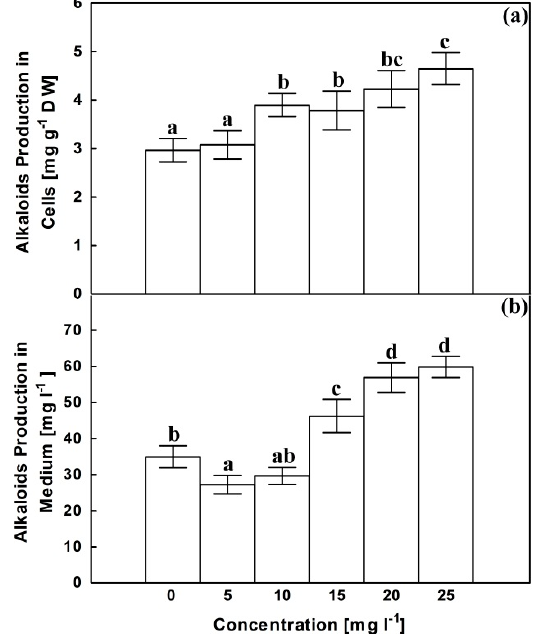
Figure 4. Effects of AgNPs at concentrations of 5, 10, 15, 20 and 25 mg L − 1 on alkaloids content in dried cells ( a ) and growth medium ( b ) of C. roseus cell suspension cultures. Means ± standard deviations (SDs), n = 3, Values followed by the same small letter within each column are not significantly different at p ≤ 0.05.